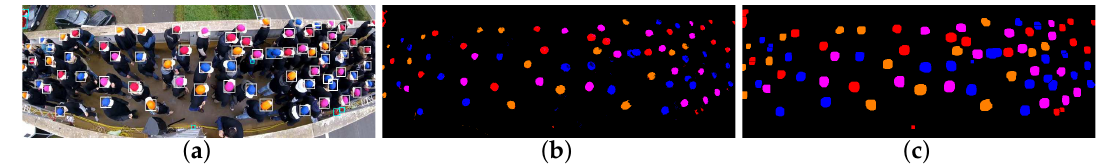
Figure 10. Example of the color segmentation and detection algorithm: ( a ) original frame with indication of the true detected objects (white squares) and false detected objects (cyan squares), ( b ) binary mask before applying the morphological operations and ( c ) final binary image with indication of the detected